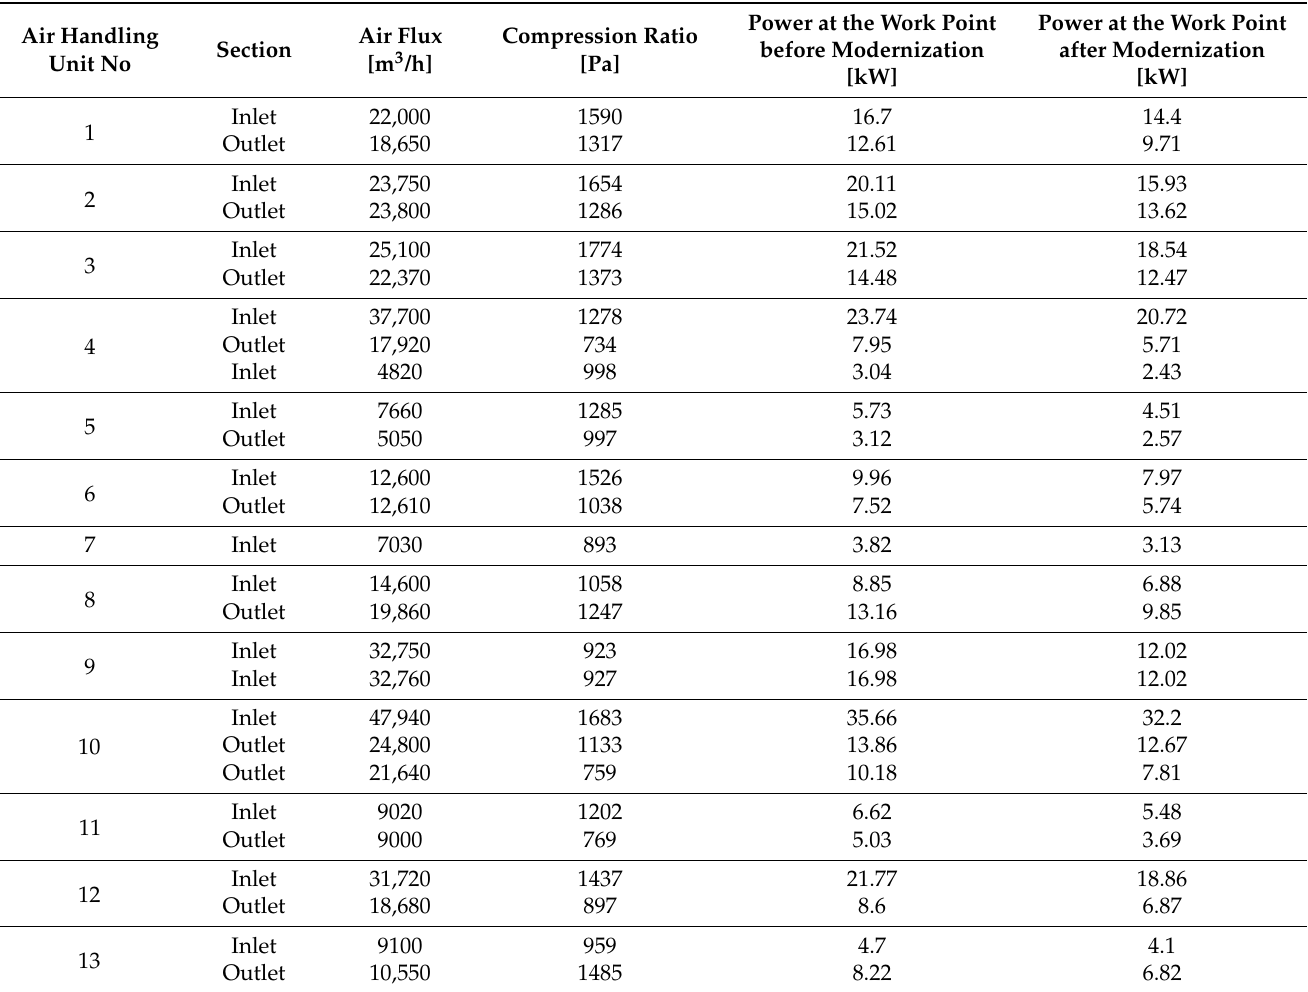
Table 3. Comparison of power at the operating point before and after